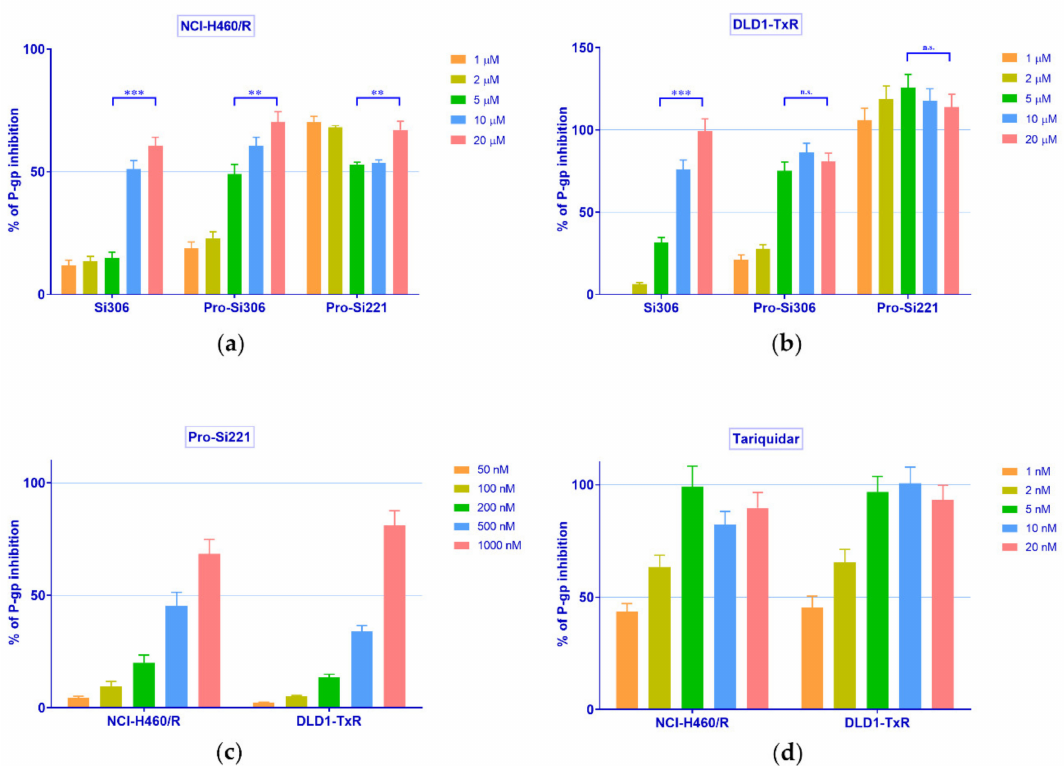
Figure 3. Concentration-dependent inhibition of P-gp activity. Rho 123 accumulation in ( a ) NCI-H460/R and ( b ) DLD1-TxR cell lines was assessed after the application of increasing concentrations of Si306, pro-Si306, and pro-Si221 (1, 2, 5, 10, 20 µ M). The lower range of concentrations for ( c ) pro-Si221 (0.05, 0.1, 0.2, 0.5, 1 µ M) and ( d ) TQ (1, 2, 5, 10, 20 nM) in NCI-H460/R and DLD1-TxR cells. The percentage of P-gp inhibition is expressed as an increase in Rho 123 accumulation; 100% of P-gp inhibition is considered when the level of Rho123 accumulation achieves the level of Rho123 accumulation in sensitive cells. Three independent experiments were performed (a minimum of 10,000 events were collected for each experimental sample). A statistically significant difference between 5 µ M and 20 µ M treatments with Si306, pro-Si306, and pro-Si221 is presented in ( a , b ): p < 0.01 (**), p < 0.001 (***), not significant